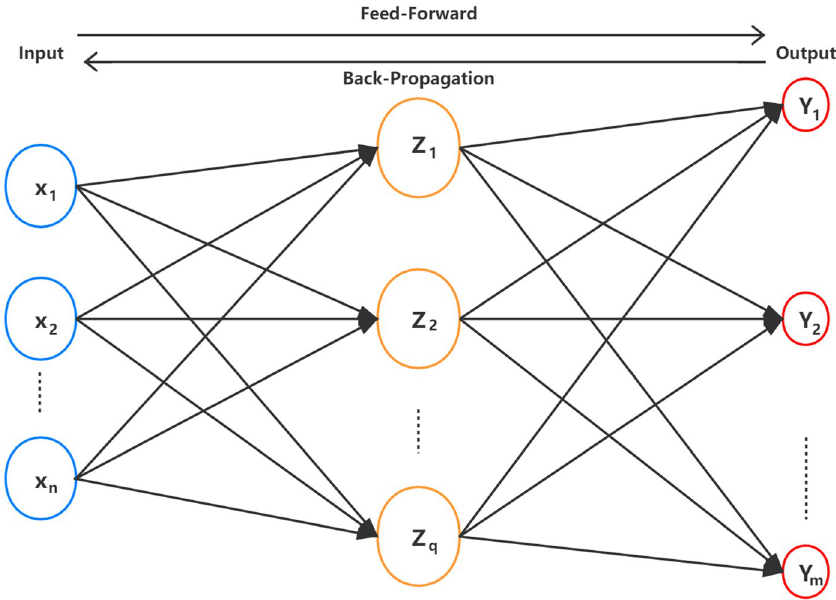
x by A 1 , and produces A 2 and D 2 , and so on. The wavelet decomposition of the input x analysed at level n has the structure of [ A n , D n , D n 1 , . . . , D 2 , D 1 ] 35 . − Back-propagation neural network (BPNN) model. BPNN is a supervised self-learning algorithm designed to minimize the mean square error between the computed output of the network and desired output 36 . As shown in Fig. 2, BPNN was formed by one input layer, one or more hidden layers, and one output layer. In this research, BPNN was trained with the Levenberg–Marquardt (LM) algorithm. It is a classic back-propagation algorithm that uses heuristics, relies on numerical optimization techniques to minimize and accelerate the cal- culation process, leading to a faster training 37 . The optimal number of hidden neurons for BPNN was deter- mined by trial and error procedures.